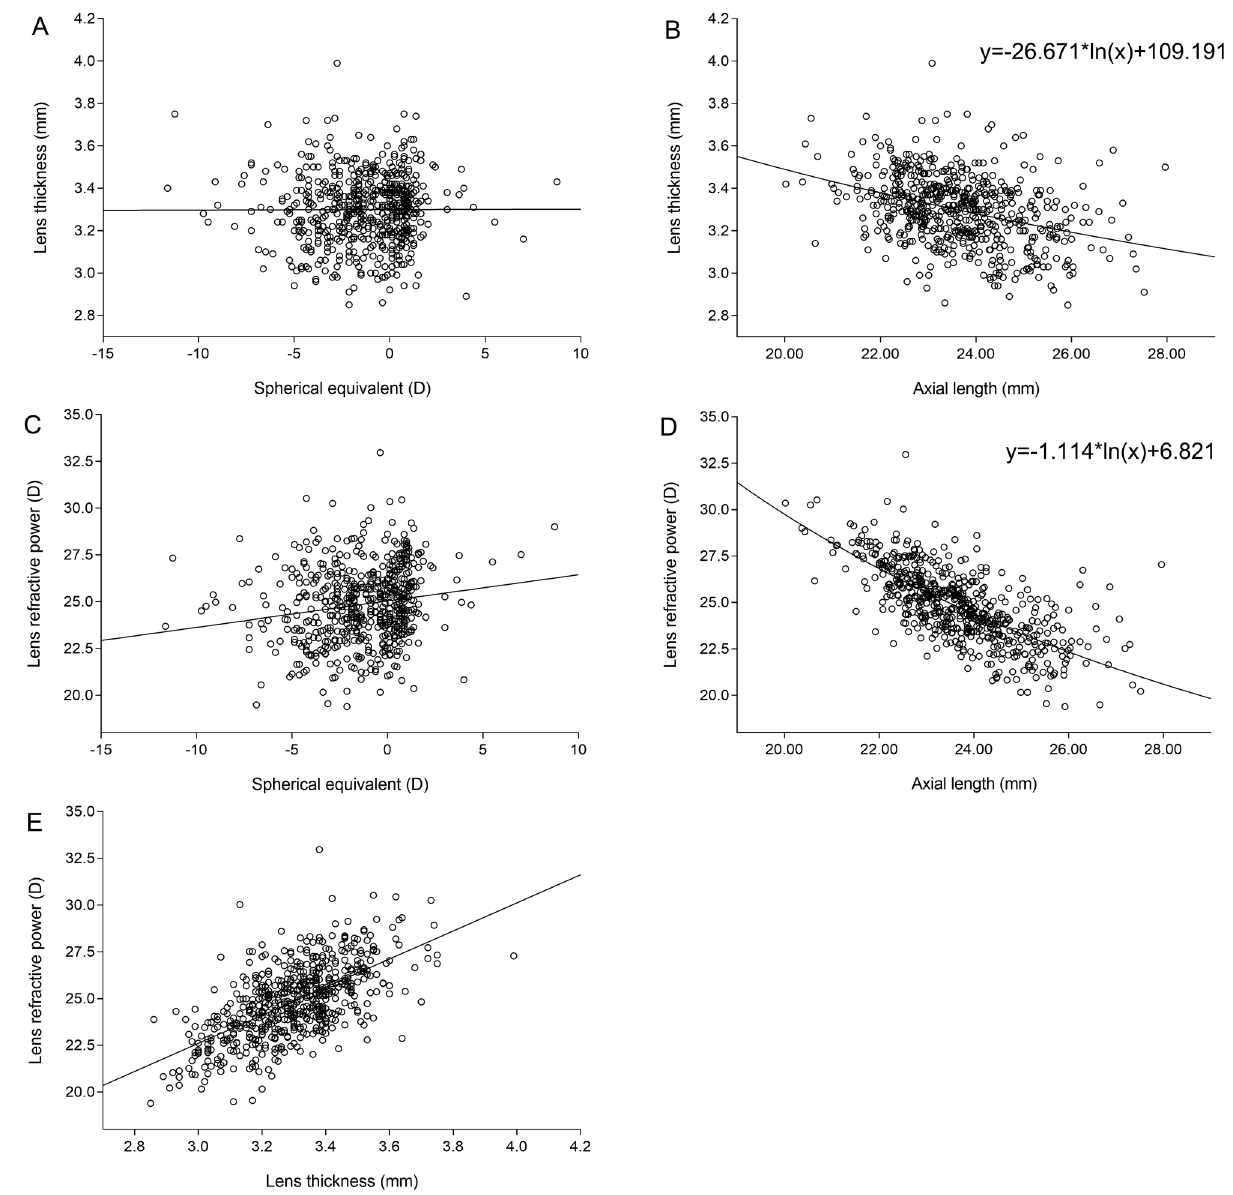
Figure 3. Graph showing the association between lens thickness and refractive error (A) ; the logarithmic curve-fitting showing the association between lens thickness and axial length (B) ; graph showing the association between refractive lens power and refractive error (C) ; the logarithmic curve-fitting showing the association between refractive lens power and axial length (D) ; graph showing the association between refractive lens power and lens thickness (E) .